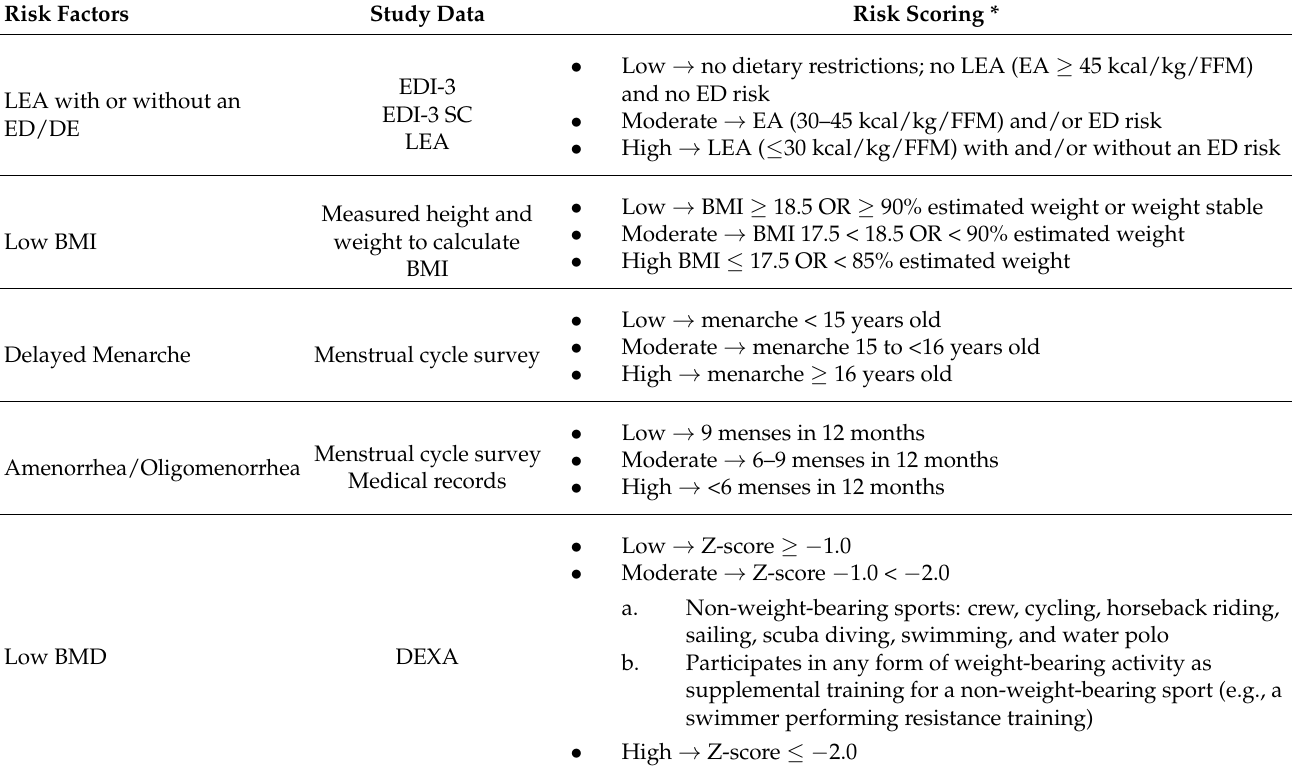
Table 1. Application of Triad CRA for